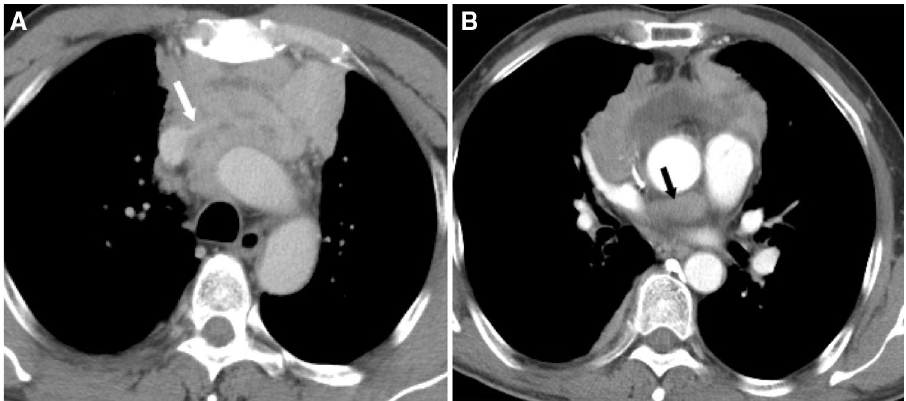
Figure 1. Thymic squamous carcinoma in a 54-year-old man with vessel invasion and pericardial mass. Contrast enhanced CT scan (Axial 5.0 mm) obtained at the level of the aortic arch ( A ) and pulmonary trunk ( B ) shows the interface between the tumor and the left brachiocephalic vein was blurred and the lumen was quite narrowed and compressed (white arrow). A soft tissue mass was seen inside and around the pericardium (black arrow). This patient had tumor progression and died 43.9 months since the first CT